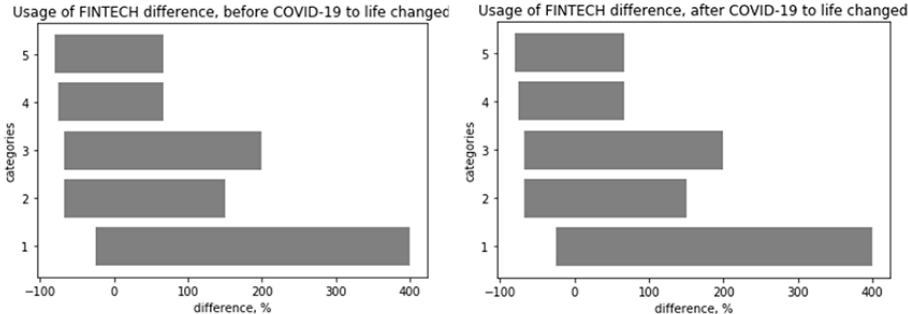
Figure 1. The relative difference of FINTECH usage before and after COVID-19 compared to daily life change. Source: own research.